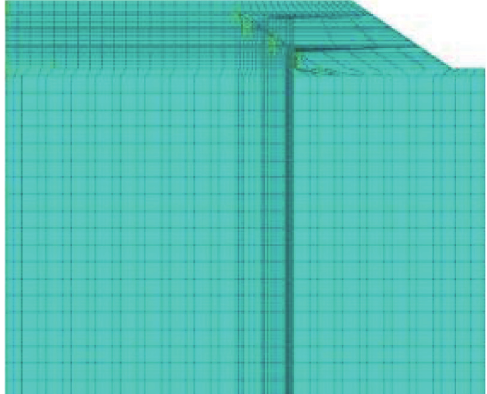
Figure 2: Finite element mesh diagram of the widened subgrade.